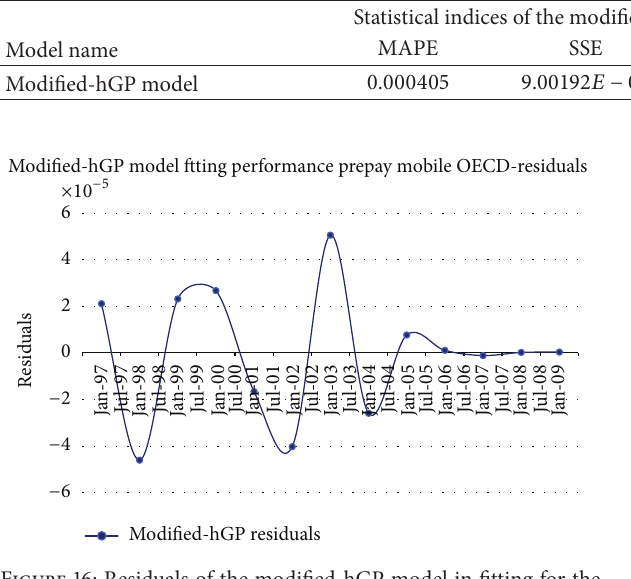
Table 4: Statistical indices in fitting process of the modified-hGP model for the OECD mobile prepay subscribers. Statistical indices of the modified-hGP for OECD mobile prepay subscribers